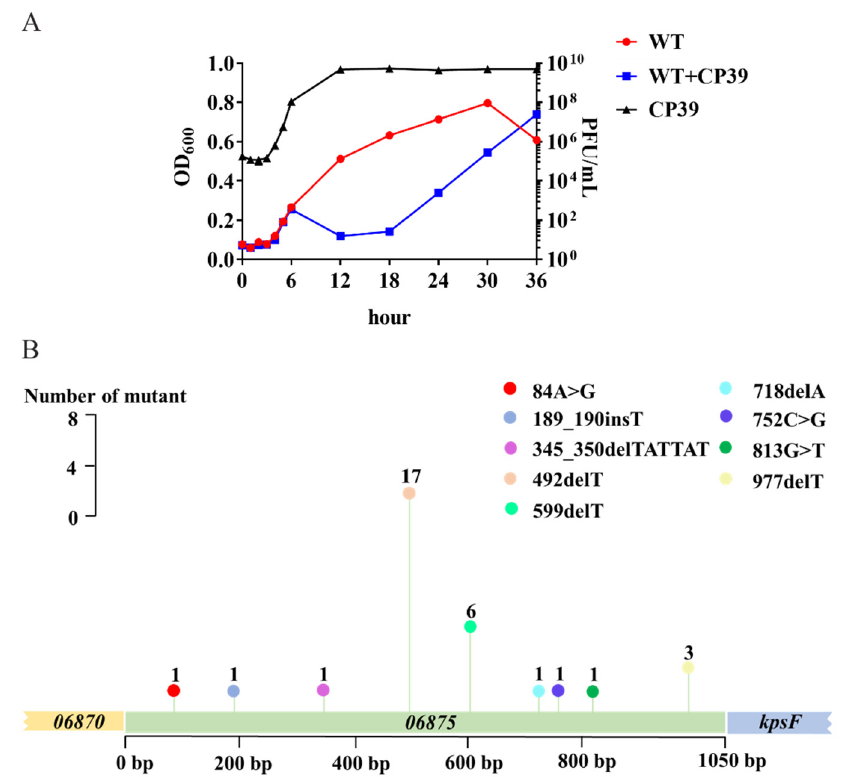
Figure 4. The occurrence of phage resistance in C. jejuni NCTC12662 and the mutation frequency of the 06875 gene during CP39 infection. ( A ) Generation of phage lysis curves and phage-resistant bacterial outgrowth. NCTC12662 was infected with CP39 for 36 h at an MOI of 0.01. NCTC12662 without phage was served as the wild type (WT) control. The one-step growth curve of phage CP39 was evaluated by the PFU/mL at each time point. ( B ) The mutation frequency of the 06875 gene. The mutation frequency was calculated as the number of 06875 mutant from 100 phage-resistant colonies by PCR sequencing. A “>” represented the original base pair was replaced by another base pair; A “_” represented an insertion (ins) or deletion (del) was occurred between base pairs.